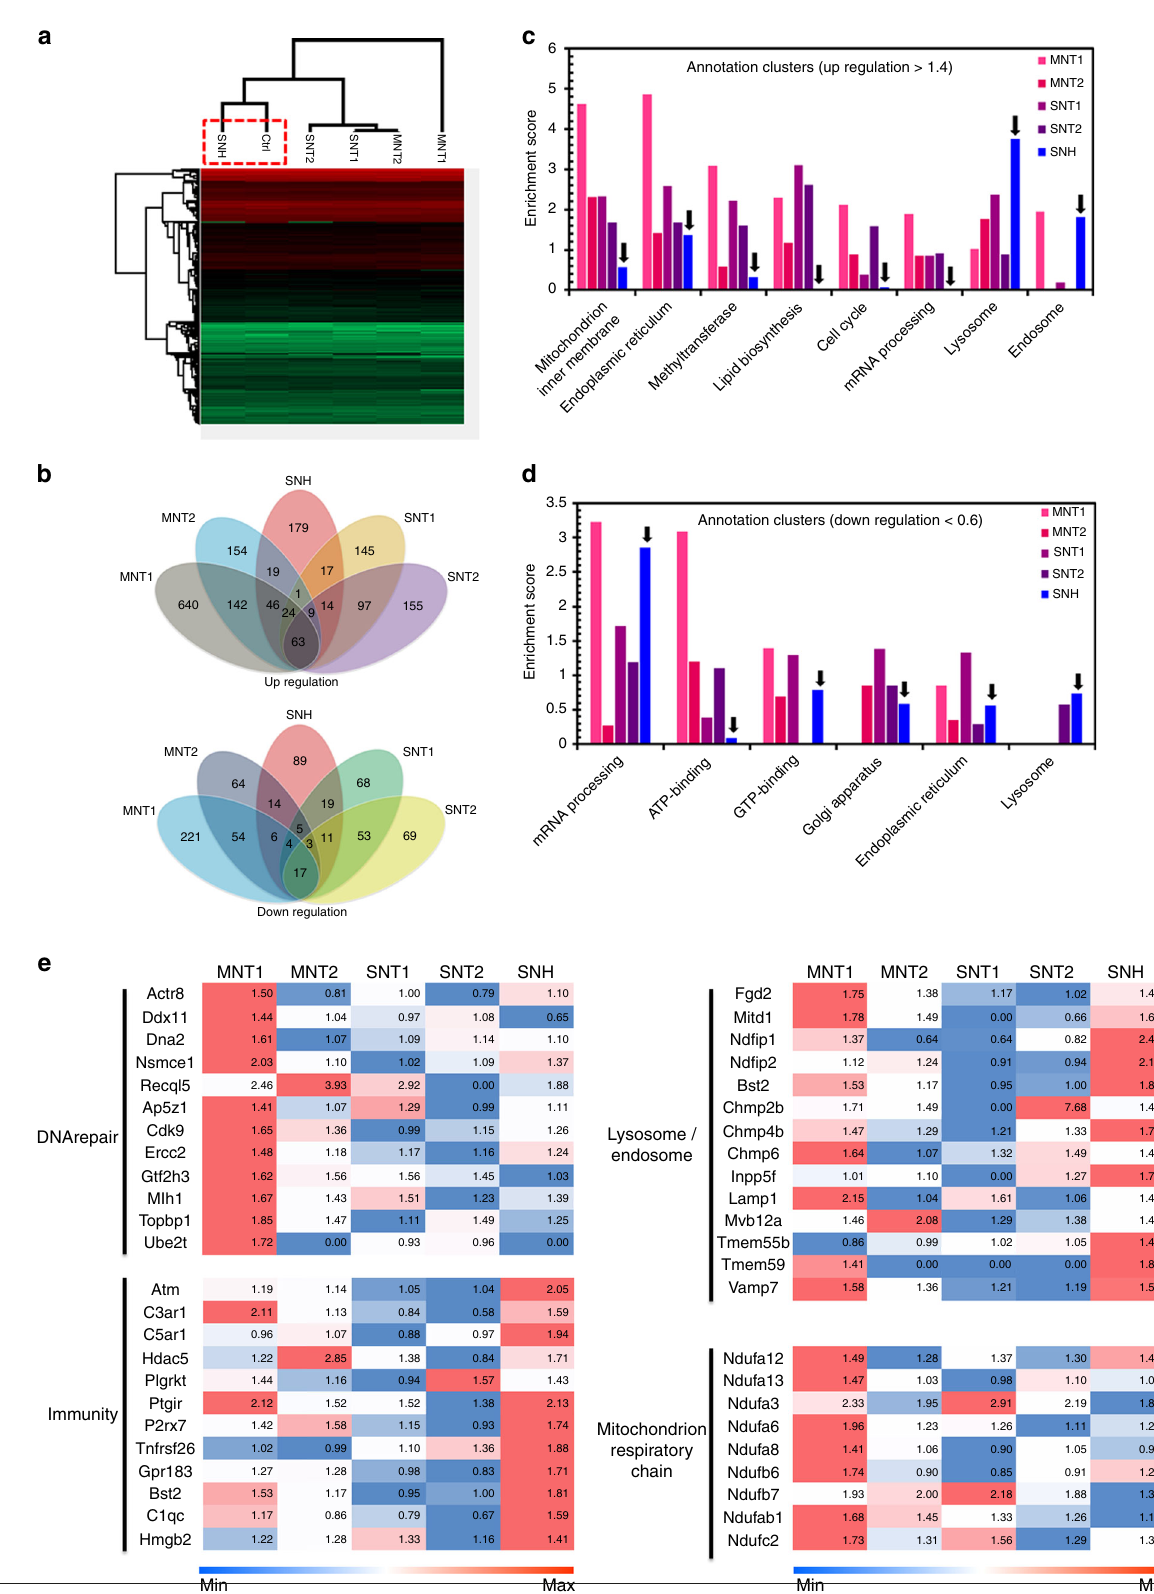
Fig. 4 SNH generated less impact on protein expression than CNT. a Hierarchical clustering analysis on the changes of cellular proteins investigated by LFQ proteomics after incubation of nanocarbons. b The Venn diagrams of cellular proteins with more than 40% expression change over control group after treatment of nanocarbons. c , d The gene functional annotation clustering of the c upregulated and d downregulated proteins based on enrichment analysis after the incubation of different nanocarbons. e The heat maps on the expression comparison of changed proteins that involved in part of key cellular processes after the incubation of nanocarbons. The values in heat maps represented the expression ratios of identi fi ed proteins compared to control